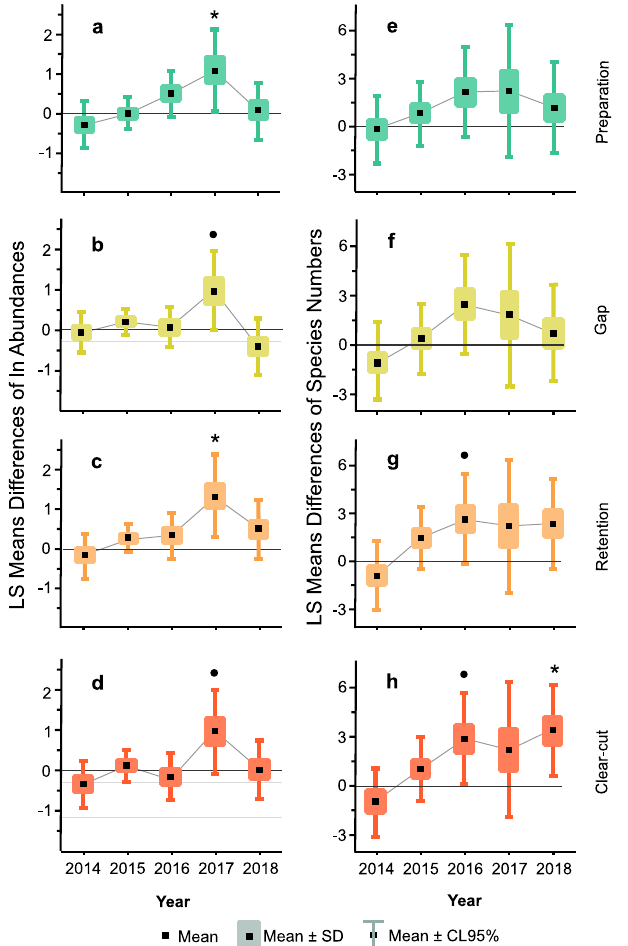
Figure 2. Least square mean differences between different treatments and control in ln(abundance) ( a-d ) and species richness ( e–h ) over the studied period. Significance of differences from control, separately for each year across the treatments, were evaluated by Tukey HSD test in the applied Linear Mixed-effect Models, with dots denoting marginal trends (0.05 < P < 0.1), asterisks denoting significance (P <